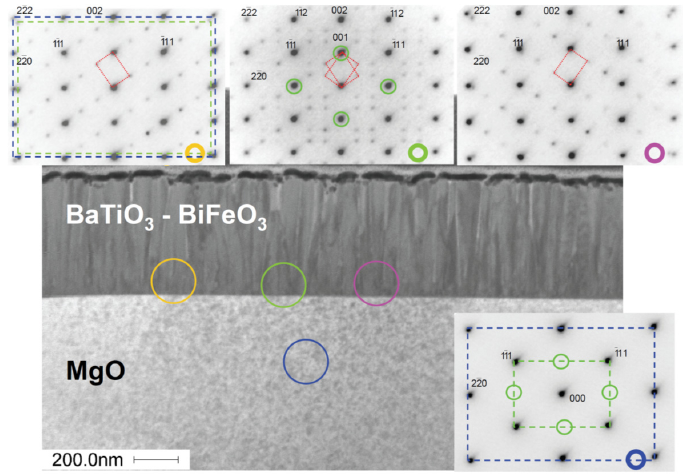
Figure 4. Scanning transmission electron microscopy (STEM) bright ‐ field image of the BaTiO 3 ‐ BiFeO 3 composite film grown at 0.01 mbar oxygen pressure shown as the (110) cross ‐ section. Clearly visible is the high density of dislocation lines in this particular composite film. The colored energy dispersive X ‐ ray spectroscopy (EDX) maps demonstrate the homogeneous distribution of elements Ba, Fe, Ti and Bi in the plane of the cross ‐ section. The gold film results from the extraction of the TEM cross ‐ section out of the planar film sample using a focused ion beam. For more EDX maps and elemental analyses, see the Supplementary Materials, Figures S4, S6, S8 and S9.